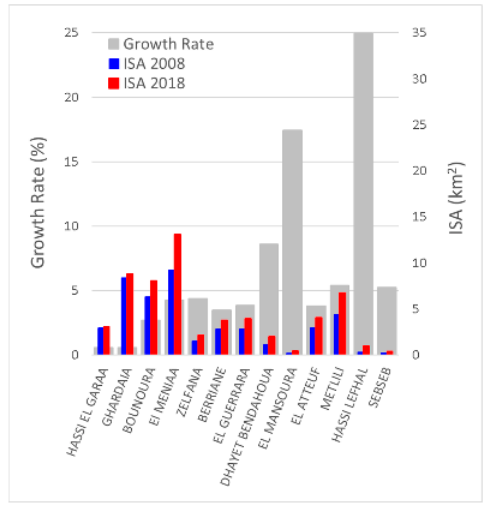
Figure 20. Impervious surface area (ISA) (km 2 ) and its growth rate (1/10 of percent) for the communes in the Ghardaia wilaya between 2008 and 2018.